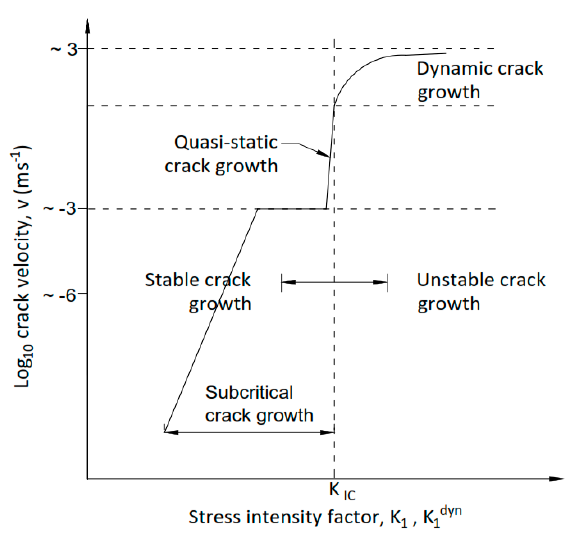
Figure 12. Crack growth states in rock materials. Subcritical crack growth after Atkinson [86], Lockner and Madden [86,87] and dynamic crack growth, after Bieniawski